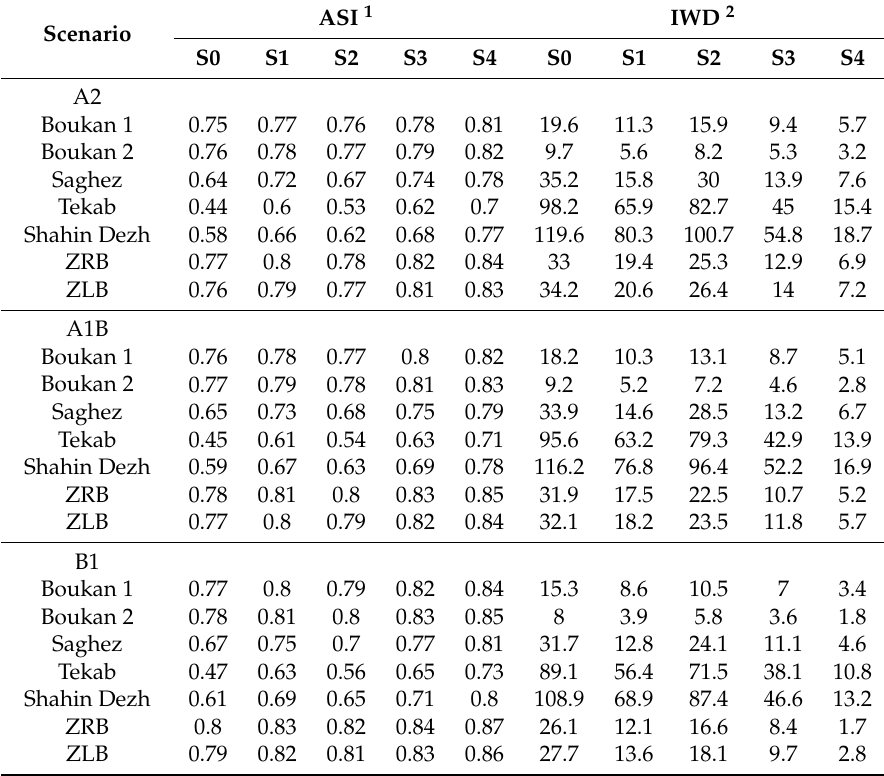
Table 6. Evaluation of agricultural sustainability indices and irrigation water deficit for agriculture